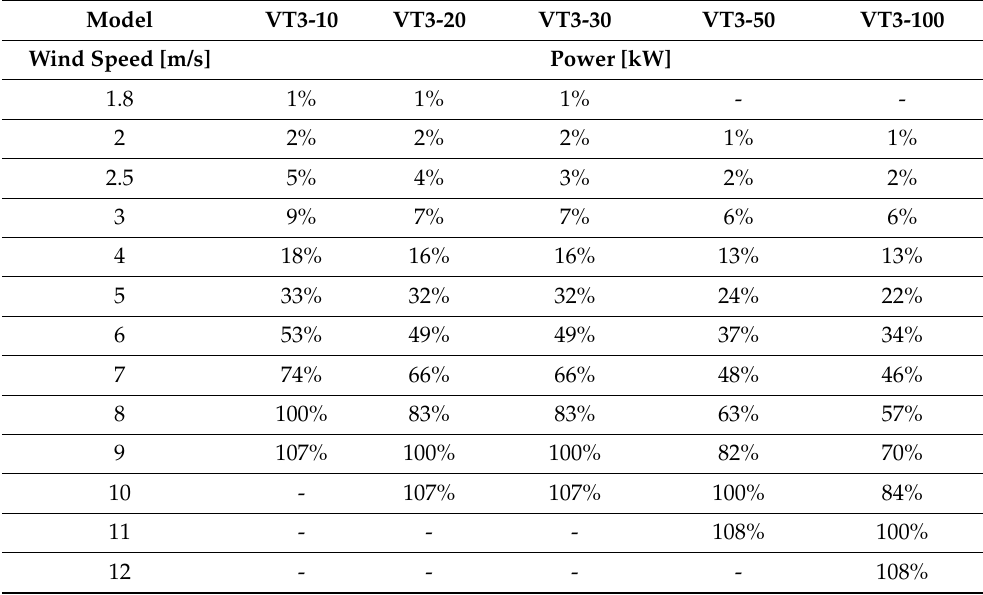
Figure 9. Distribution of the achieved power of HAWT and VAWT turbines depending on the wind speed. Table 8. Characteristics of the generated power depending on the wind speed [38].